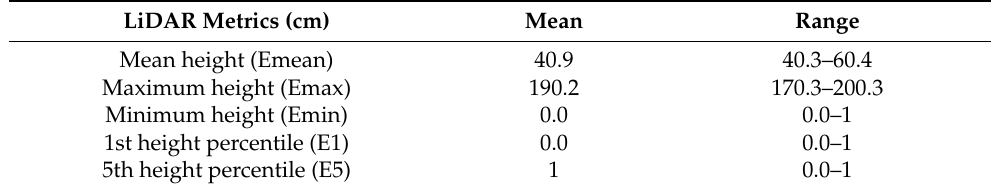
Table 6. Mean and range variation of LiDAR metric values (cm) used in the gorse shrubland